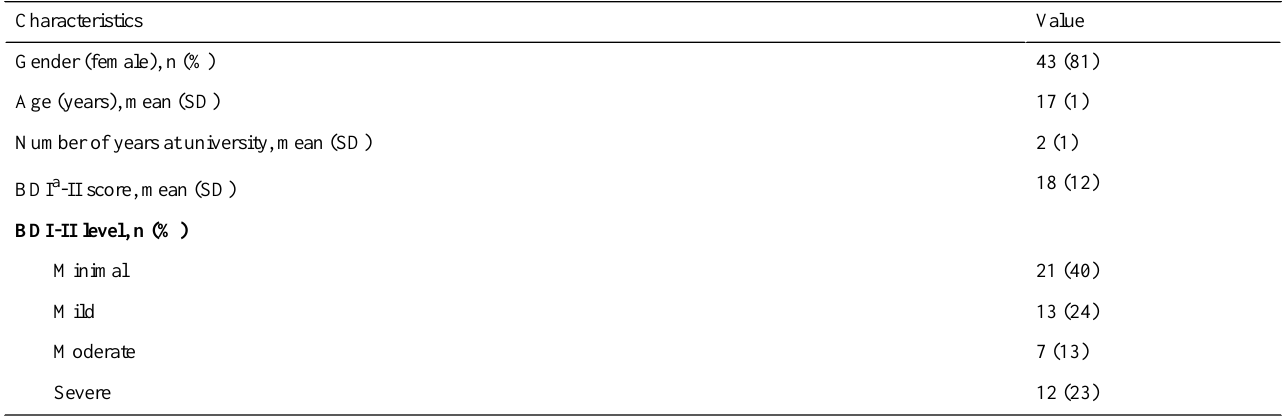
Table 1. Participant statistics (N=53).